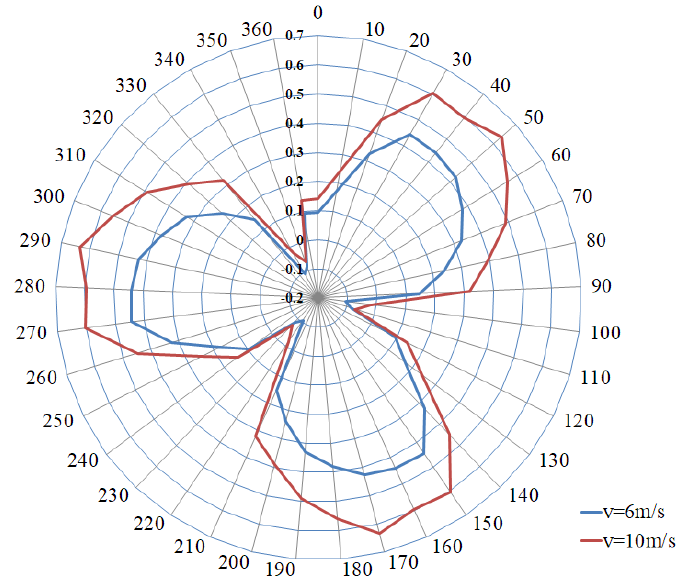
Figure 13. Radar chart of C ts of 3-bladed LDCS as a function of azimuth. Next, the lower wind speed was also selected. The velocity and vorticity diagrams explain the occurrence of C ts -max and C ts -min at the corresponding azimuth under U = 6 m/s. Figure 14 displayed a cloud magnitude diagram of the velocity of three-bladed LDCS when U = 6 m/s, θ = 30° and θ = 100°. Figure 15 showed a cloud magnitude diagram of vorticity of three-bladed LDCS when U = 6 m/s, θ = 30° and θ = 100°.